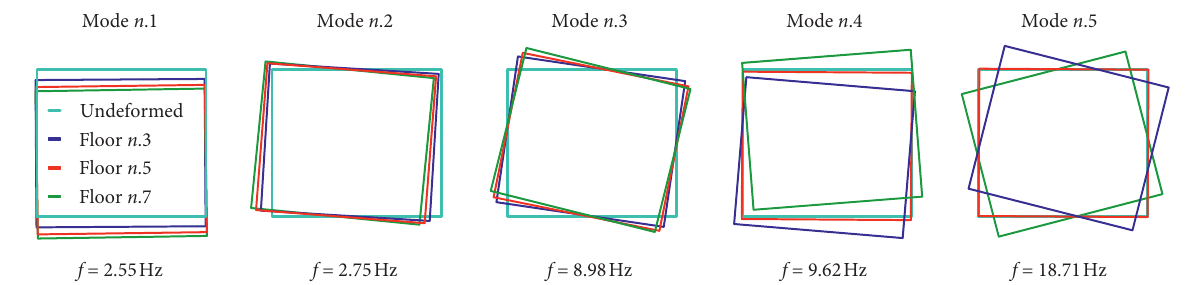
Figure 4: Natural vibration modes experimentally